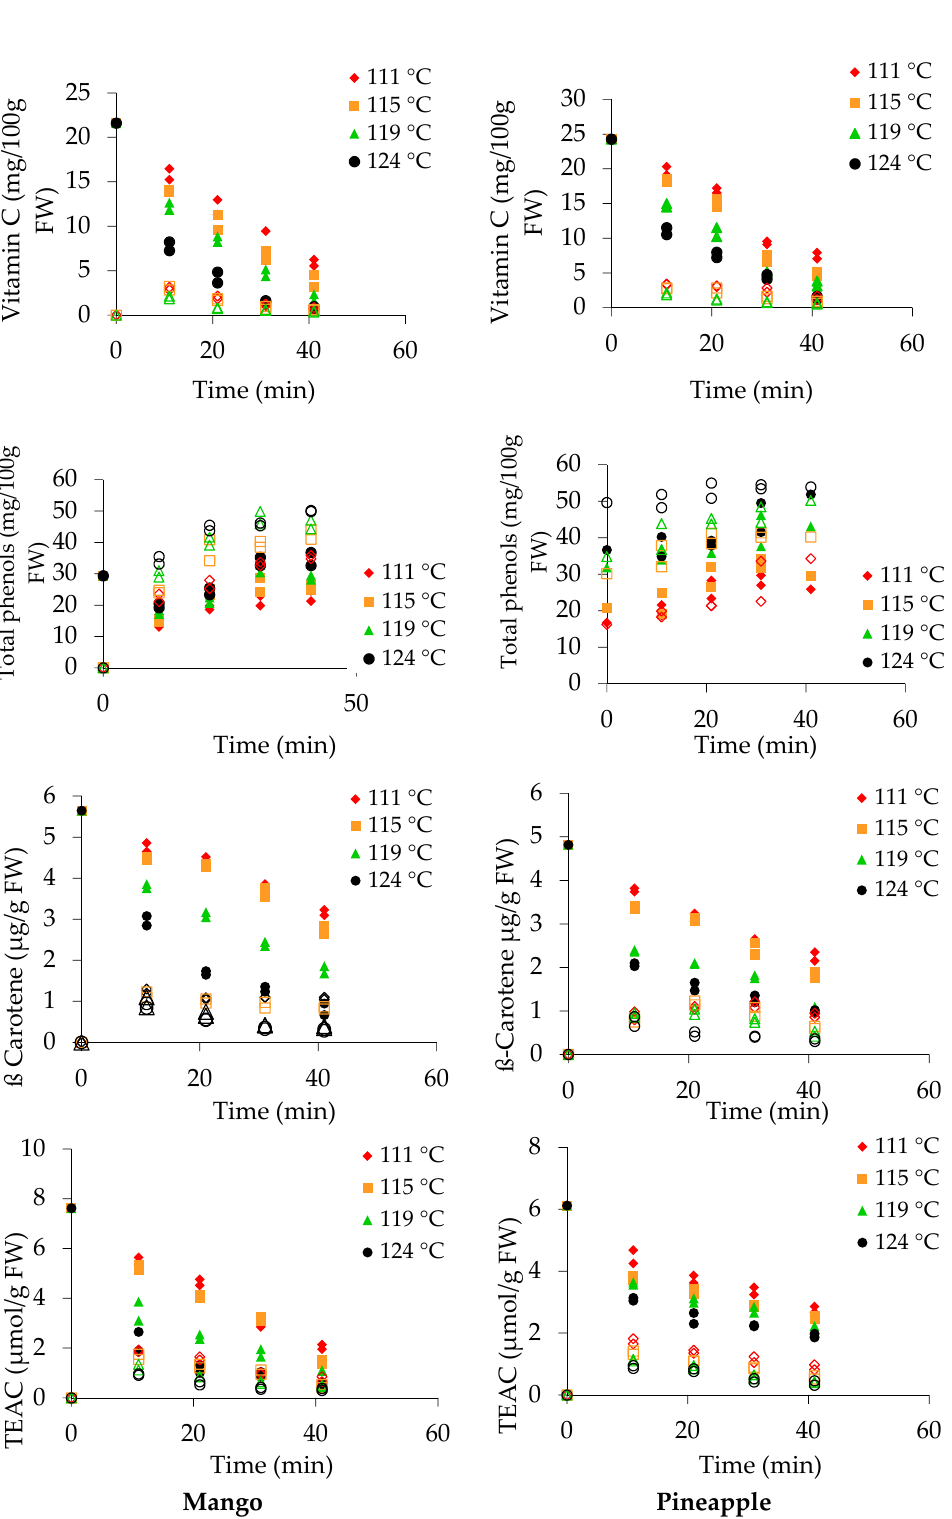
Figure 1. Vitamin C, total phenols, β -carotene, and trolox equivalent antioxidant capacity (TEAC) in pieces (closed symbols) and syrup (open symbols) during the canning of mango and pineapple at different temperatures. The legend represents the steady state coldest spot temperature in the can measured by the iButton.